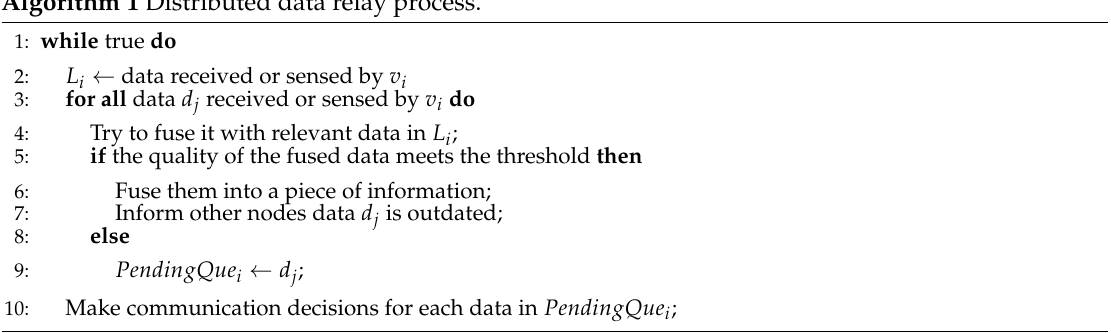
Algorithm 1 Distributed data relay